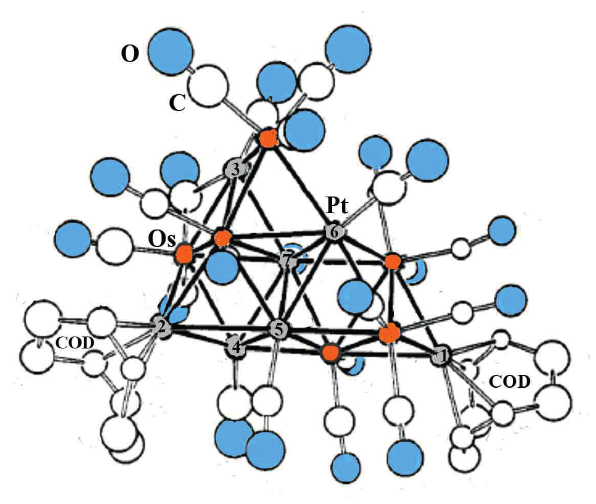
Pt Os (CO) ] 2 7 6 21